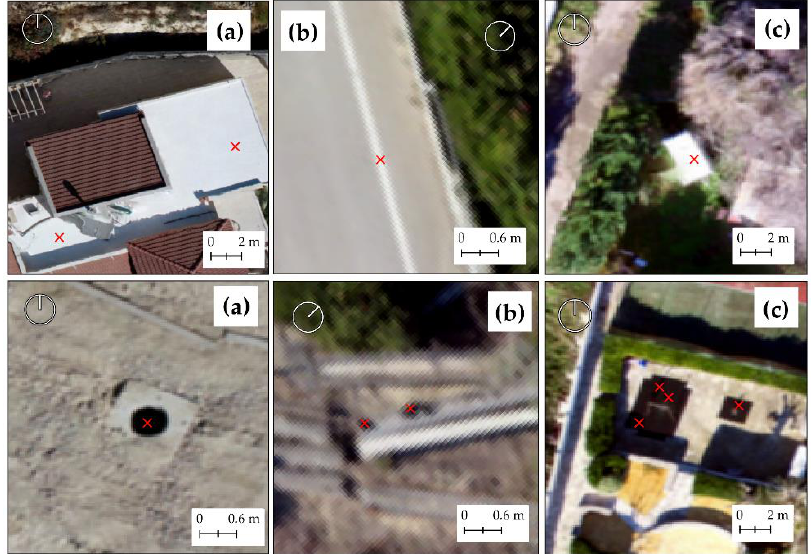
Figure 2. Example of high ( top ) and low ( bottom ) reflectance targets selected for each case study. ( a – c ) represent the three scenarios as proposed in Table 1. The round icon identifies the north orientation of the areas.